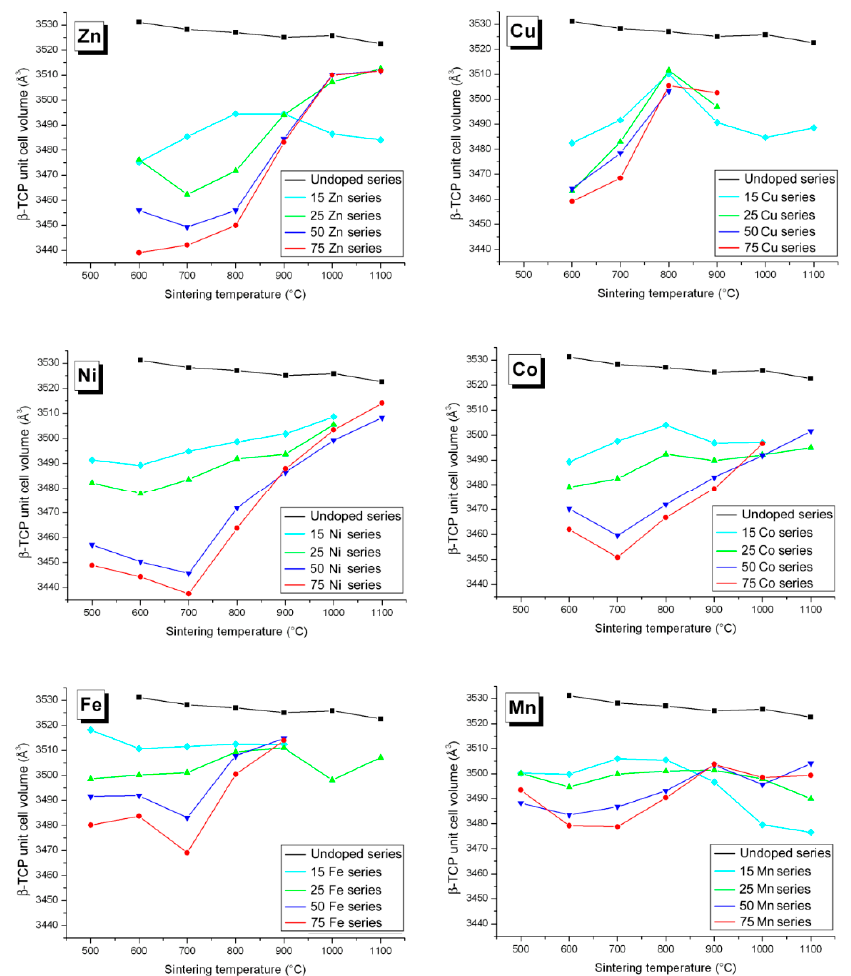
Figure 5. Variation in the unit cell volume of the β -TCP phase from all Zn-, Cu-, Ni-, Co-, Fe-, and Mn-doped samples: black lines for the undoped series, light blue lines for the 15 M -T series, green lines for the 25 M -T series, dark blue lines for the 50 M -T series, and red lines for the 75 M -T series. The lines are only visual guides.